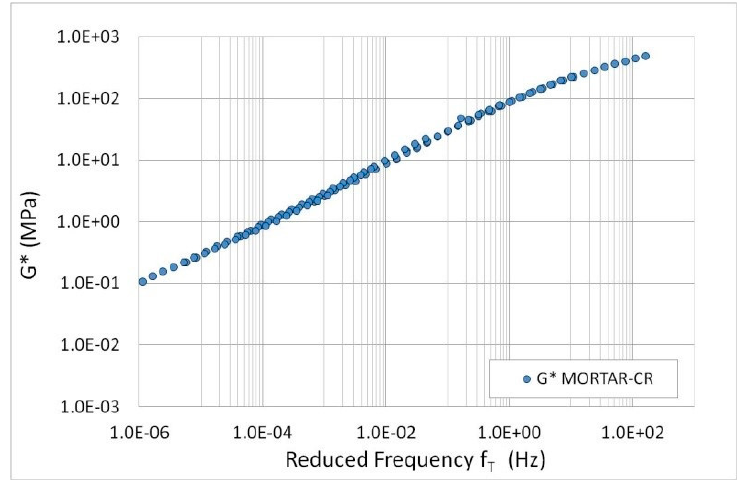
Figure 6. MORTAR-CR master curve at 20 °C.